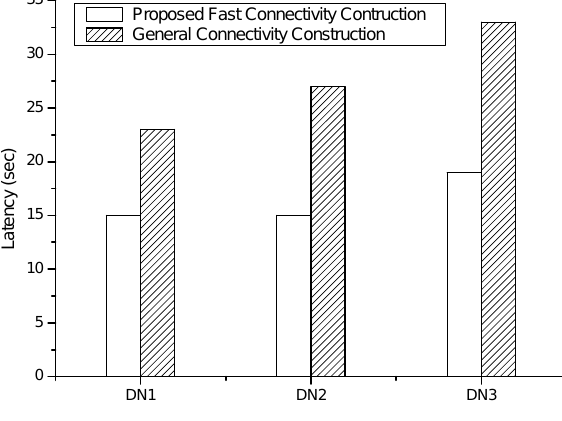
Figure 4. Latency of Routing